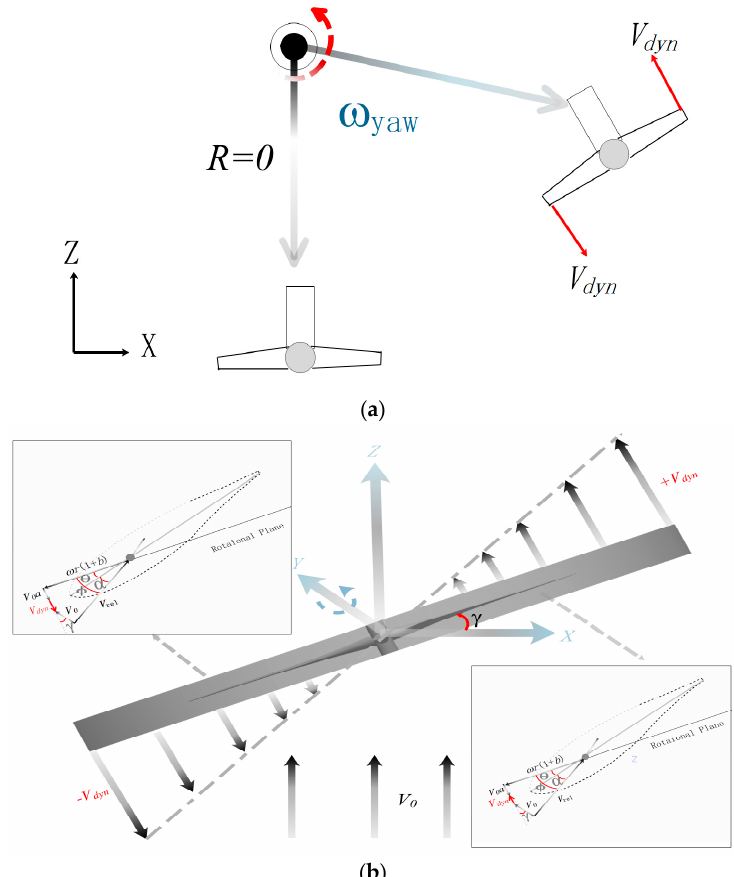
Figure 25. Velocity diagram for a blade section under dynamic yaw at radius r : ( a ) sketch of the yawing process for the velocity dynamic analysis; ( b ) velocity diagram along the span of the blade.